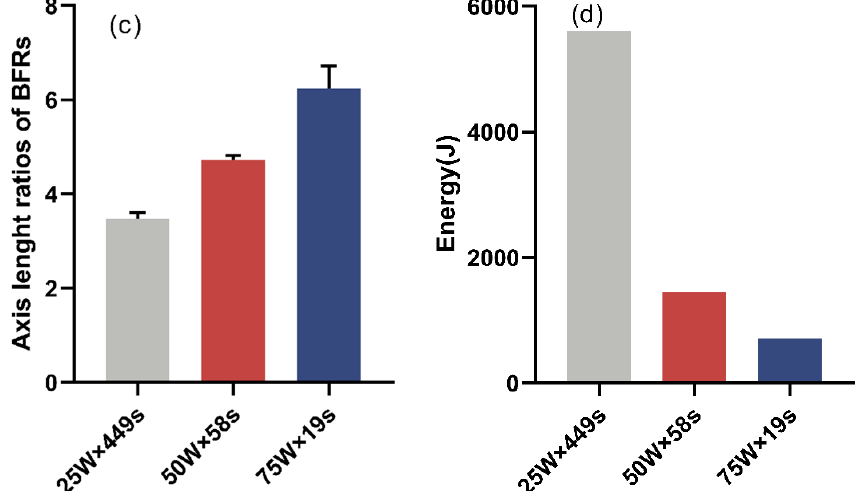
Figure 9. ( a ) Lengths ( b ) widths ( c ) axis length ratios of the BFRs, and ( d ) energy after ultrasonication with different combinations of acoustic power and time in phantom experiment.